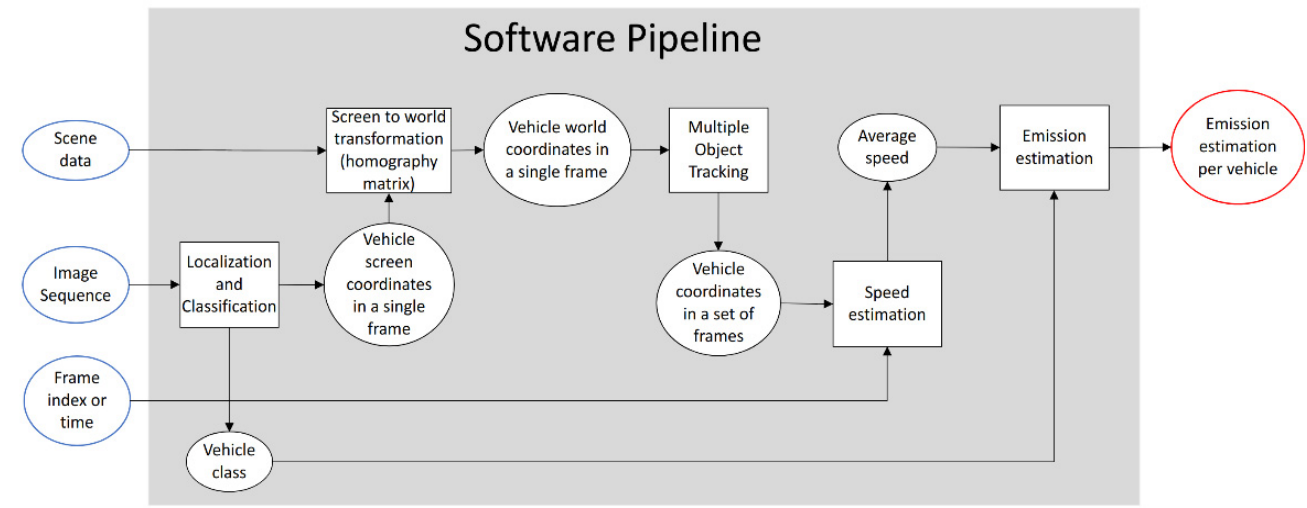
Figure 1. Diagram representing the logical structure of the pipeline that takes a sequence of images and computes an estimate of emissions for each vehicle.